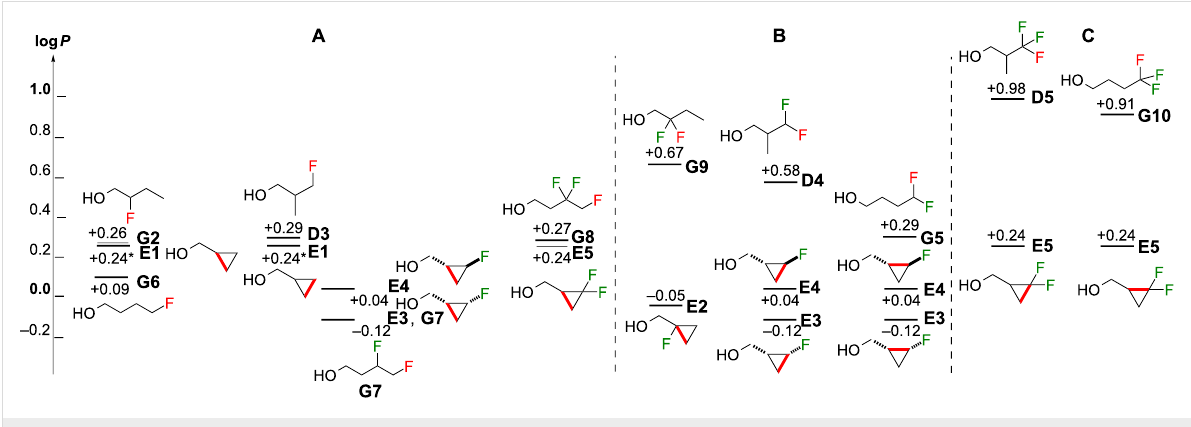
Figure 7: Comparison of lipophilicities between isopropyl and cyclopropyl substituents grouped by exchange of C–H/C–F bonds by a C – C bond (same carbon count). Organised by the exchanged fluorine being the only fluorine substituent on the carbon involved ( A ) or as part of a CF 2 ( B ) or CF 3 ( C ) group.